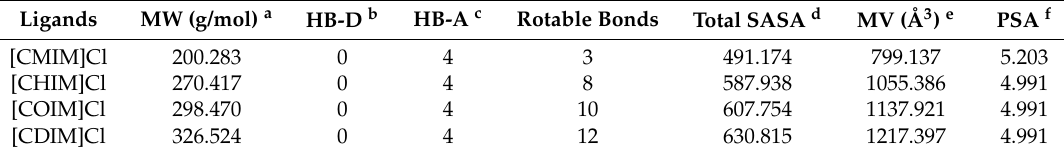
Table 4. Physicochemical descriptor calculated by QikProp simulation.